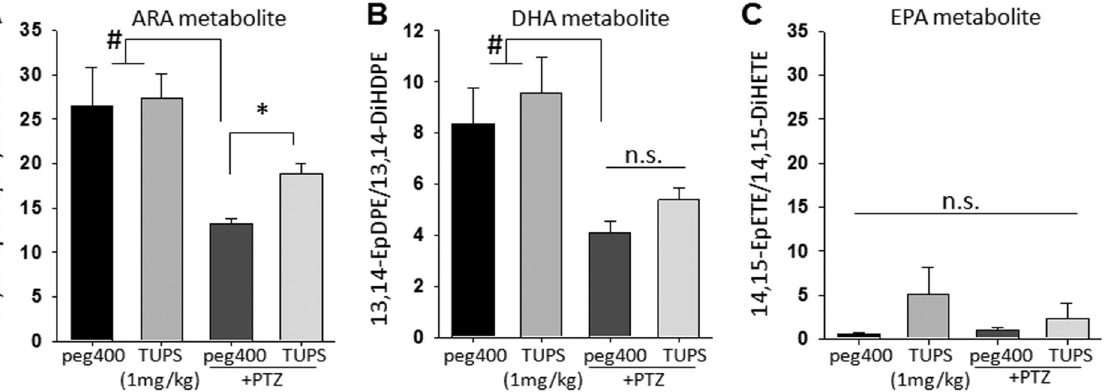
Figure 5. Brain oxylipins display decrease in response to seizure and are elevated by sEHI. ( A–C ) Bar graph of ratios of brain epoxy to dihydroxy-FAs in mice receiving vehicle (n=6, black bars), sEHI (n=6, gray bars), vehicle + PTZ (n=8, dark gray bars) and sEHI + PTZ (n=8, light gray bars). Inhibitors were administered 1 h prior to sampling, PTZ treated animals were sampled up immediately following tonic phase of the seizure. PTZ treatment resulted in a significant decrease in the levels of bioactive regioisomers 14,15-EET and 13,14- EpDPE (Kruskal-Wallis One Way ANOVA on Ranks followed by Dunn’s multiple comparison, control vs PTZ, # p # 0.05). Although in the absence of seizures sEHI did not lead to changes in the brain levels of 14,15- EET and 13,14- EpDPE, the decrease mediated by seizures was recovered by inhibition of sEH for the ARA metabolite 14,15-EET (*p=0.001) but not for the DHA metabolite 13,14-EpDPE (p=0.061). There were no significant changes in the levels of EPA derived epoxy fatty acids among